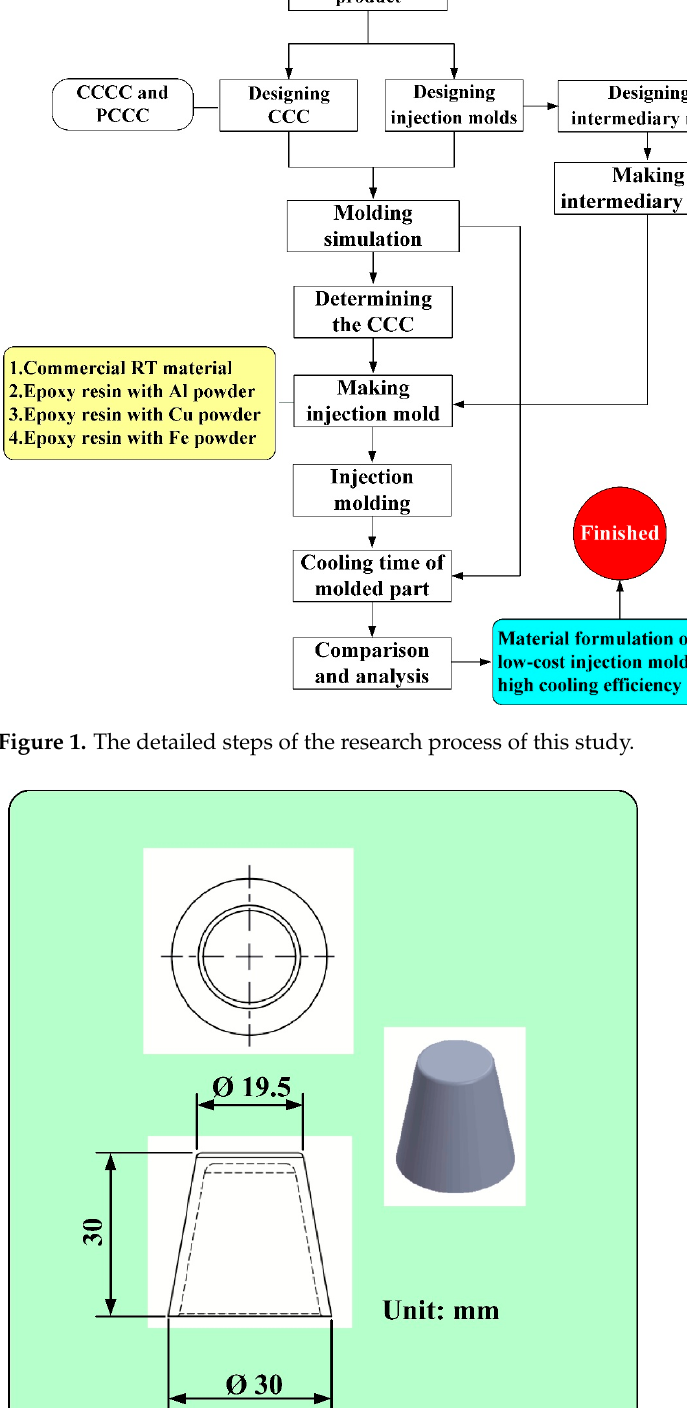
Figure 3. Schematic illustrations of the cross-section of ( a ) PCCC and ( b ) CCCC.